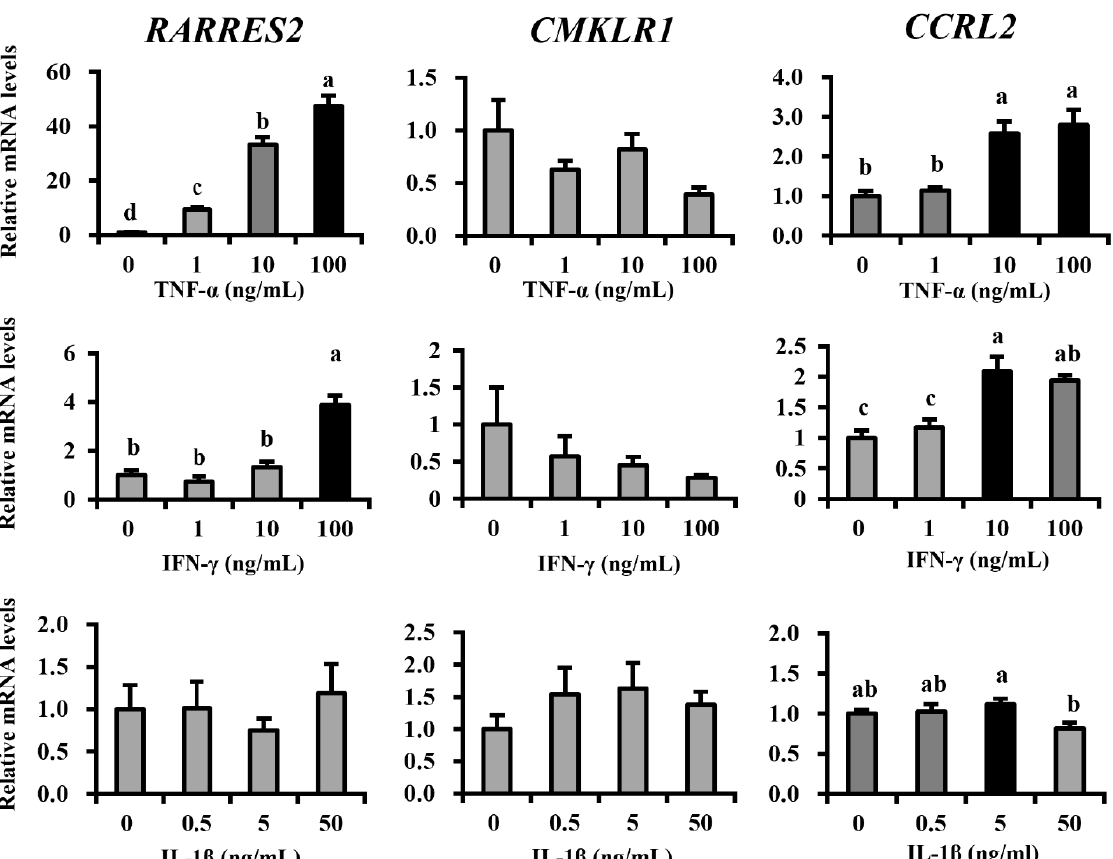
Figure 5. Inflammatory cytokines regulate chemerin and its receptor’s expression. Immortalized bovine mammary epithelial cells (MAC-T cells) were cultivated and differentiation was induced in vitro for 5 days. Differentiated MAC-T cells were treated with TNF- α , IL-1 β , or IFN- γ for 24 h at indicated concentrations ( n = 6 for each treatment concentration). Gene expression of RARRES2 encoding chemerin and genes encoding its receptors were investigated by qRT-PCR after treatments. Different letters represent statistical significance: p < 0.05 by Tukey’s HSD test.